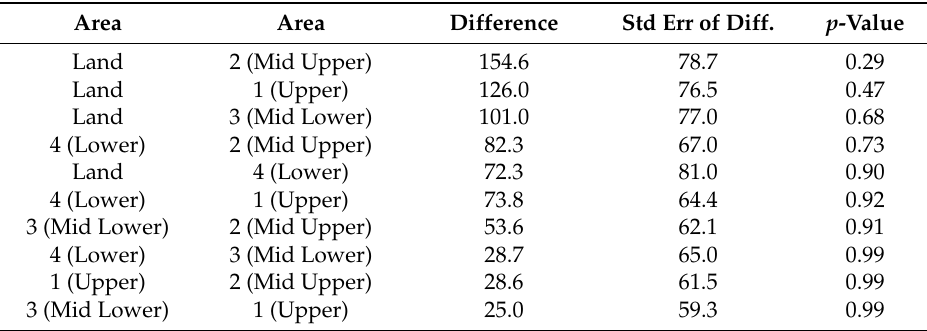
Table 3. Statistical summary of difference tests among the areas.